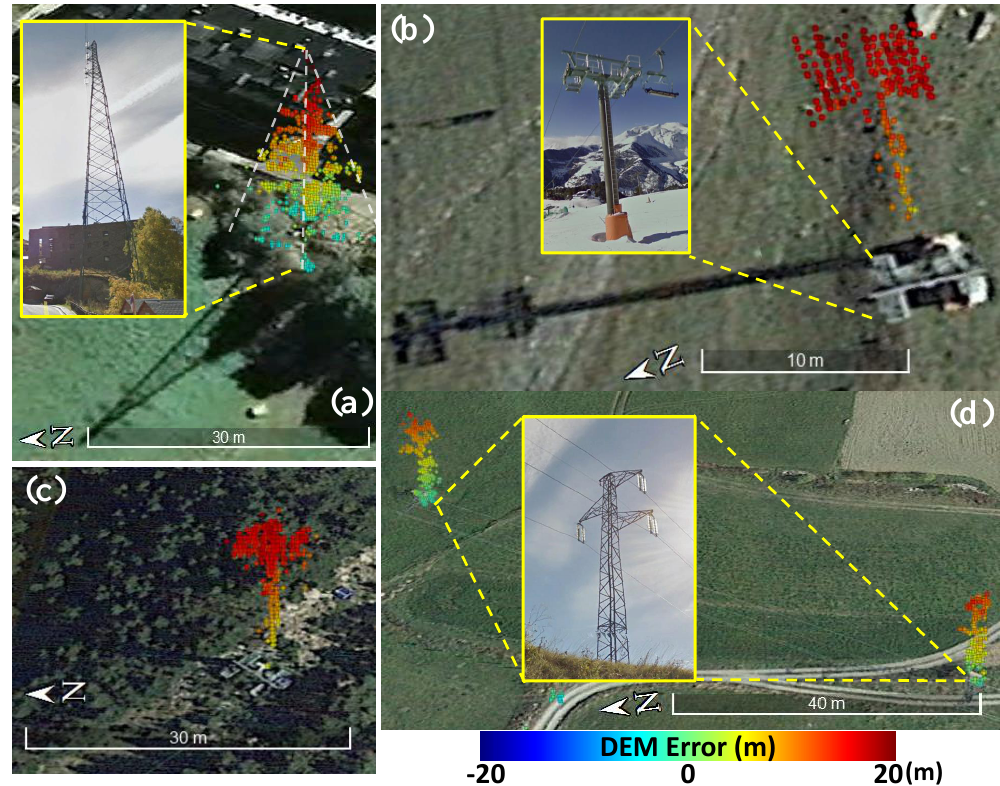
Figure 10. SHR TerraSAR-X data derived DEM errors at the locations of some manmade structures in the study area by the TPC method. ( a ) communications tower, ( b , c ) chairlifts towers and ( d ) high voltage towers. PSs have been geocoded over a GoogleEarth image using the retrieved DEM